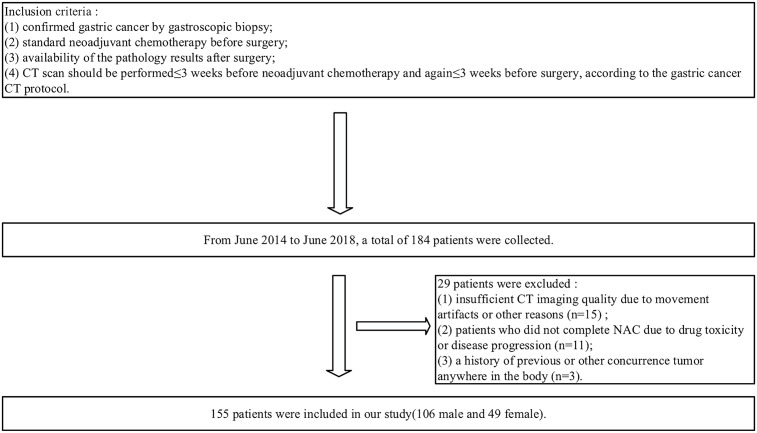
Flowchart of study enrollment.